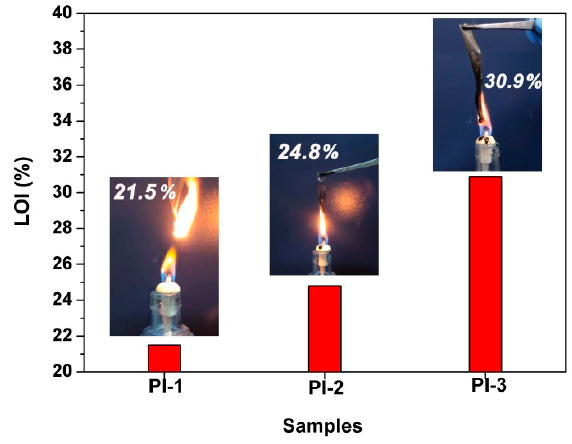
Figure 9. LOI values of PI films (insert: combustion of PI films).